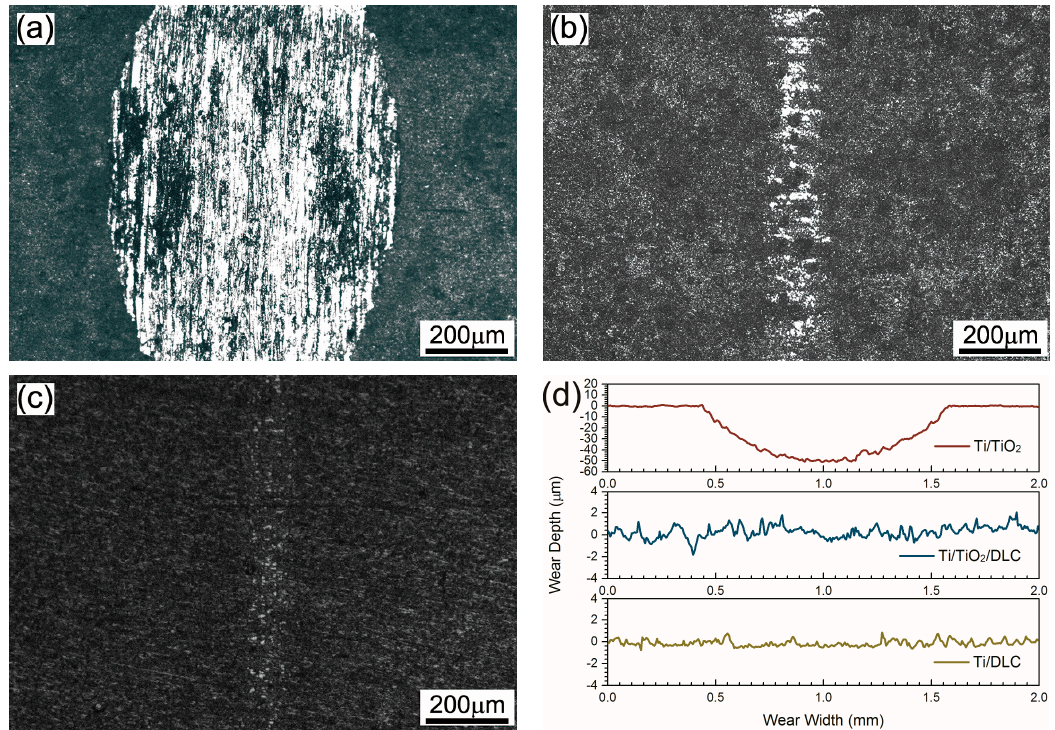
Figure 5. Optical microscope images and cross-sectional profiles of wear tracks of samples after a sliding distance of 100 m under normal load of 1 N: ( a ) Ti/TiO 2 ; ( b ) Ti/TiO 2 /DLC; ( c ) Ti/DLC; ( d ) cross-sectional profiles of wear tracks.